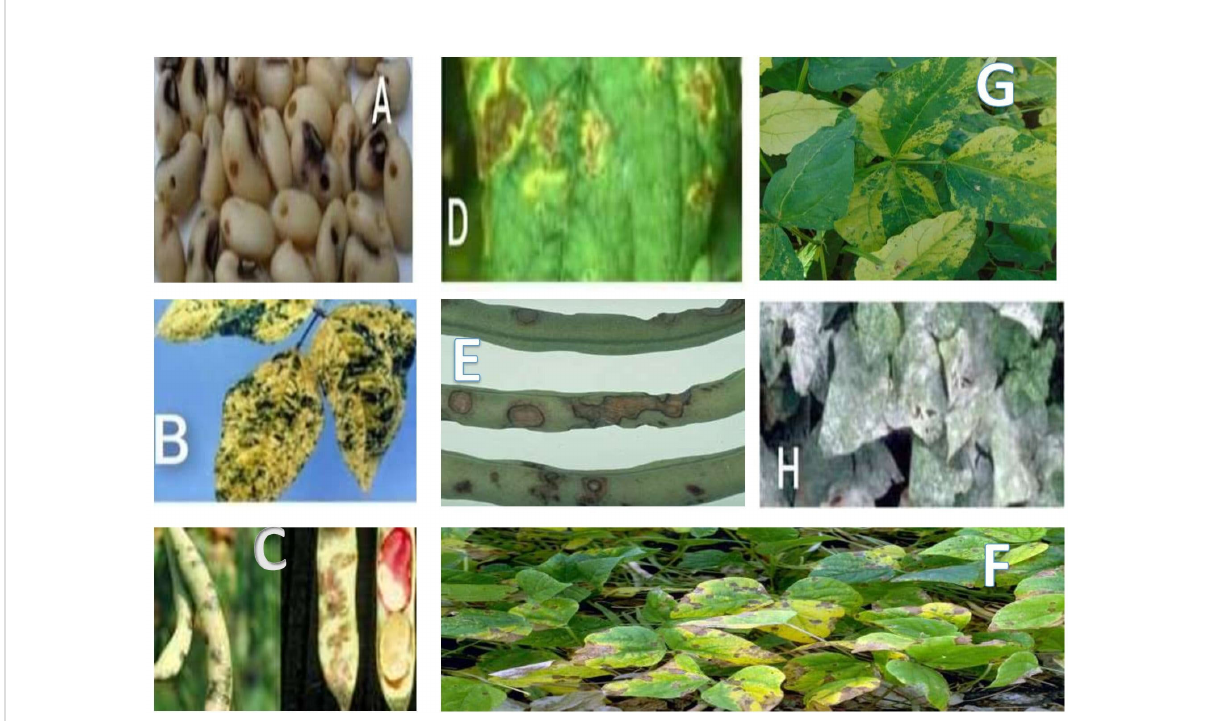
FIGURE 1 Microbial diseases of cowpea: (A) cowpea seed beetle, (B) Yellow mosaic virus infected cowpea, (C) cowpea halo blight, (D) bacterial blight, (E) anthracnose, (F) cowpea cercospora leaf spot, (G) cowpea severe mosaic virus, (H) powdery